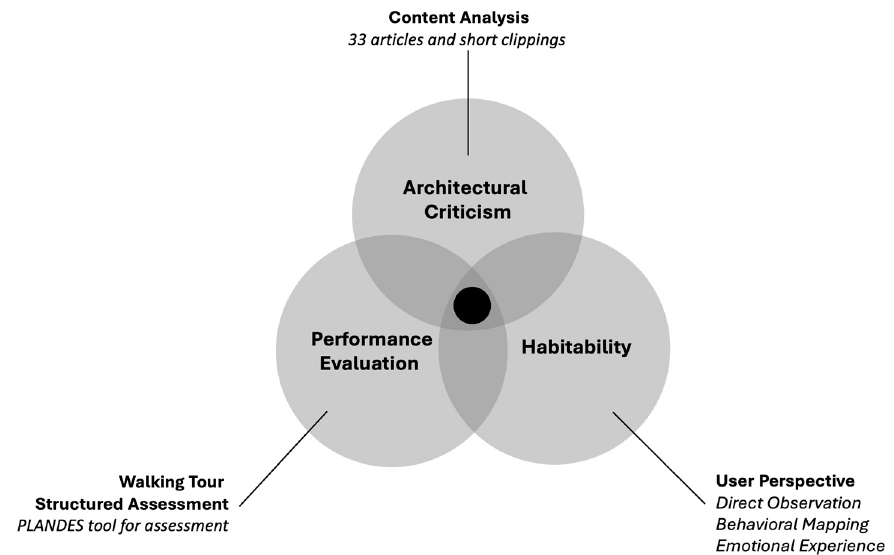
Figure 3. Multimodal framework and tools for examining the Riverside Museum in Glasgow. (Figure by A. Salama)